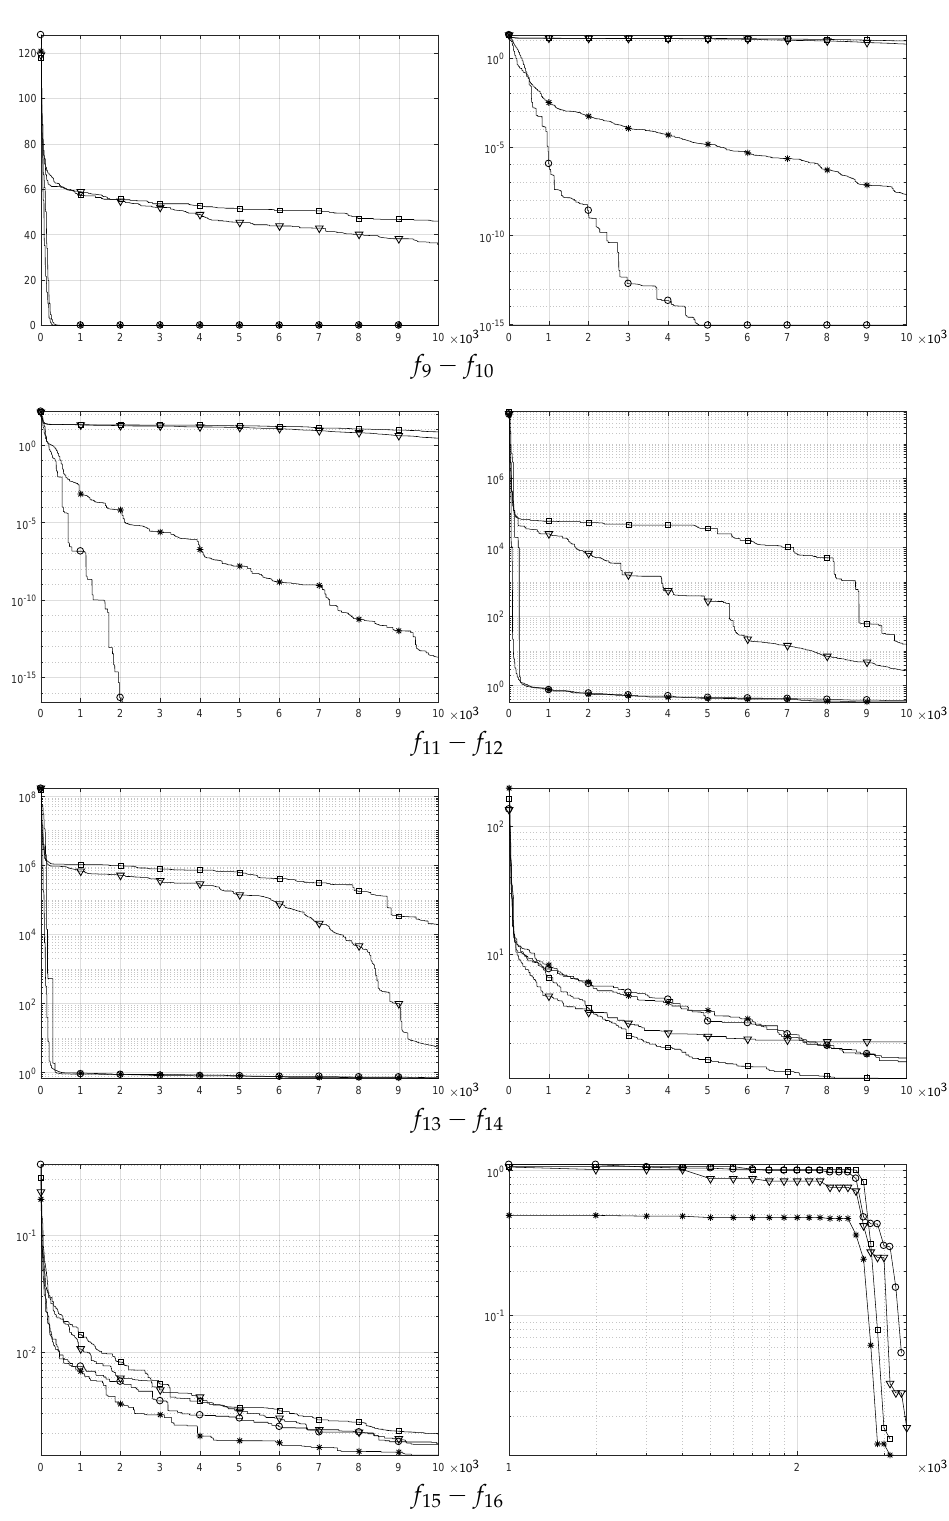
Figure 5. Average best solution (i.e., the achieved minimum, described by the y-axis) in terms of FES (the number of objective function evaluations, described by the x-axis) for the